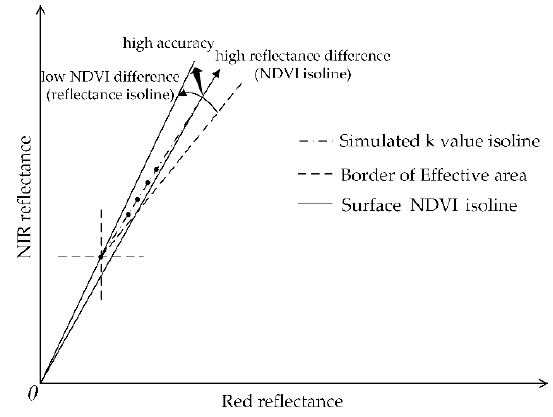
Figure 9. Relationships between reflectance difference ( RD ), NDVI difference ( ND ) and simulation accuracy.